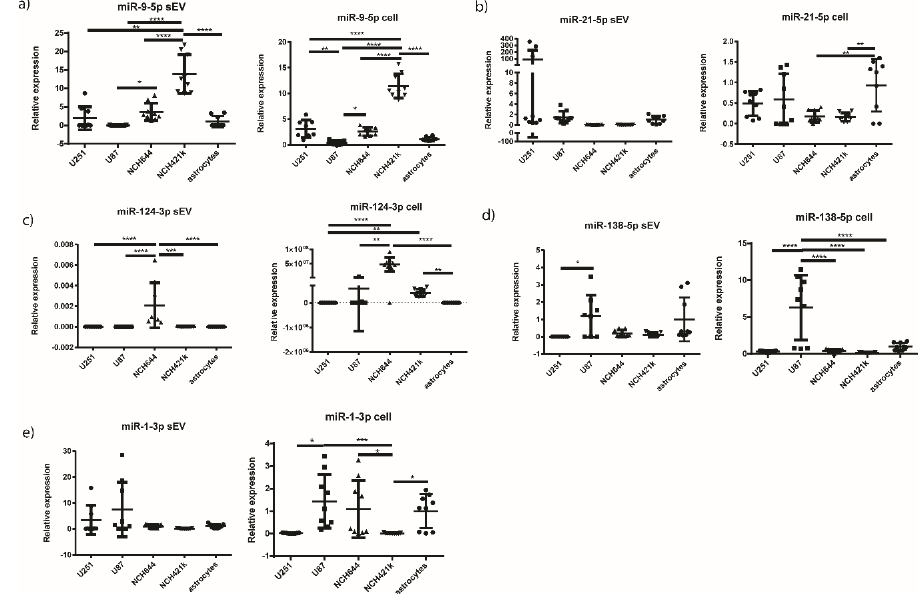
Figure 5. Relative miRNA expression in GBM cell lines and normal astrocytes and in their corresponding sEVs. Results are presented as mean, and standard deviation as error bars. ( a ) miR-9-5p, ( b ) miR-21-5p, ( c ) miR-124-3p, ( d ) miR-138-5p, ( e ) miR-1-3p. * p < 0.05, ** p < 0.01, *** p < 0.001, and **** p < 0.0001. For the miR-124-3p in sEVs, data normalized to the reference gene are presented, because the expression of miR-124-3p in the sEVs of astrocytes was below the detection threshold. GBM—glioblastoma. sEVs—small extracellular